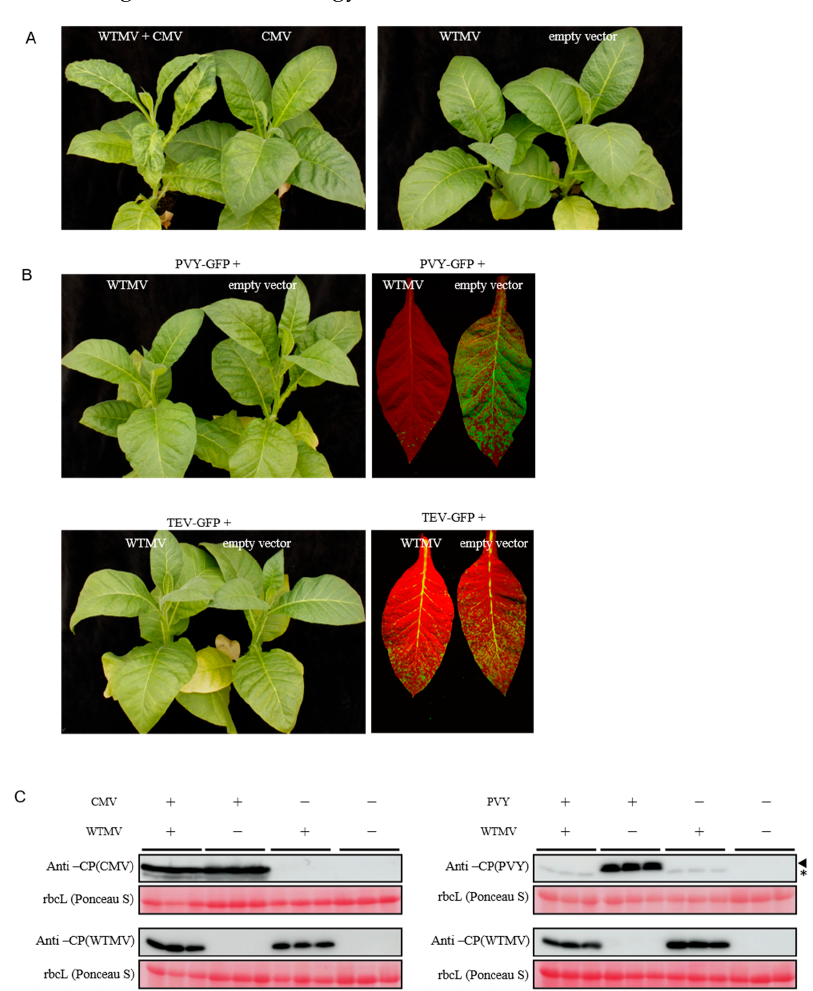
Figure 5. The coinfection of WTMV and other tobacco viruses on Nicotiana tabacum . ( A ) The tobacco variety cv. ‘Zhongyan 100’ plants were co-inoculated with WTMV or/and CMV by agroinfiltration. The plants agroinfiltrated with an empty vector were used as a control. ( B ) The tobacco variety cv. ‘Zhongyan 100’ plants were co-inoculated with WTMV or/and another potyvirus as indicated. The photographs of the whole plant and fluorescence images of the infected upper leaf were taken one-month post-infiltration. ( C ) Western blot analysis of the plants described in panels ( A , B ). The samples were obtained from the upper leaves after taking the photographs. The different lanes for each treatment indicate biological repeats. Ponceau S stained rubisco large subunit (rbcL) is used as the loading control. The PVY CP-specific band is highlighted by a black triangle. The weaker and lower-molecular-weight band positioned with an asterisk is caused by the unspecific recognition of anti-PVY polyclonal antibodies to the relatively smaller WTMV CP.